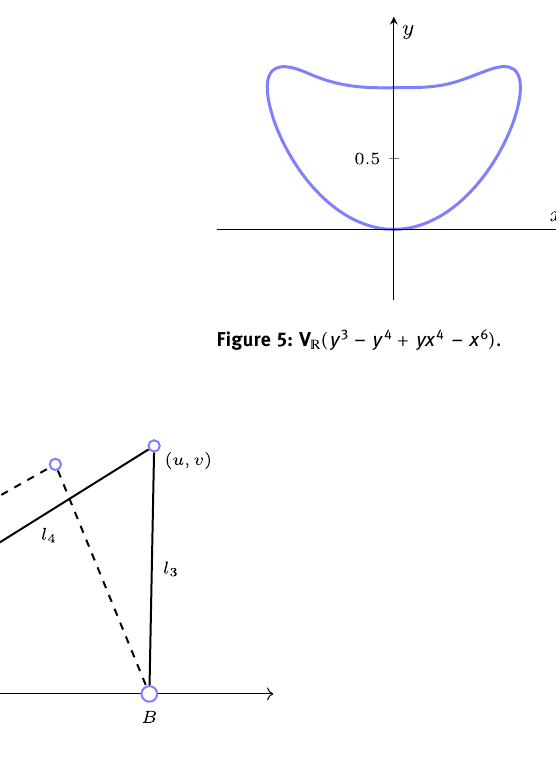
Figure 6: The four - bar